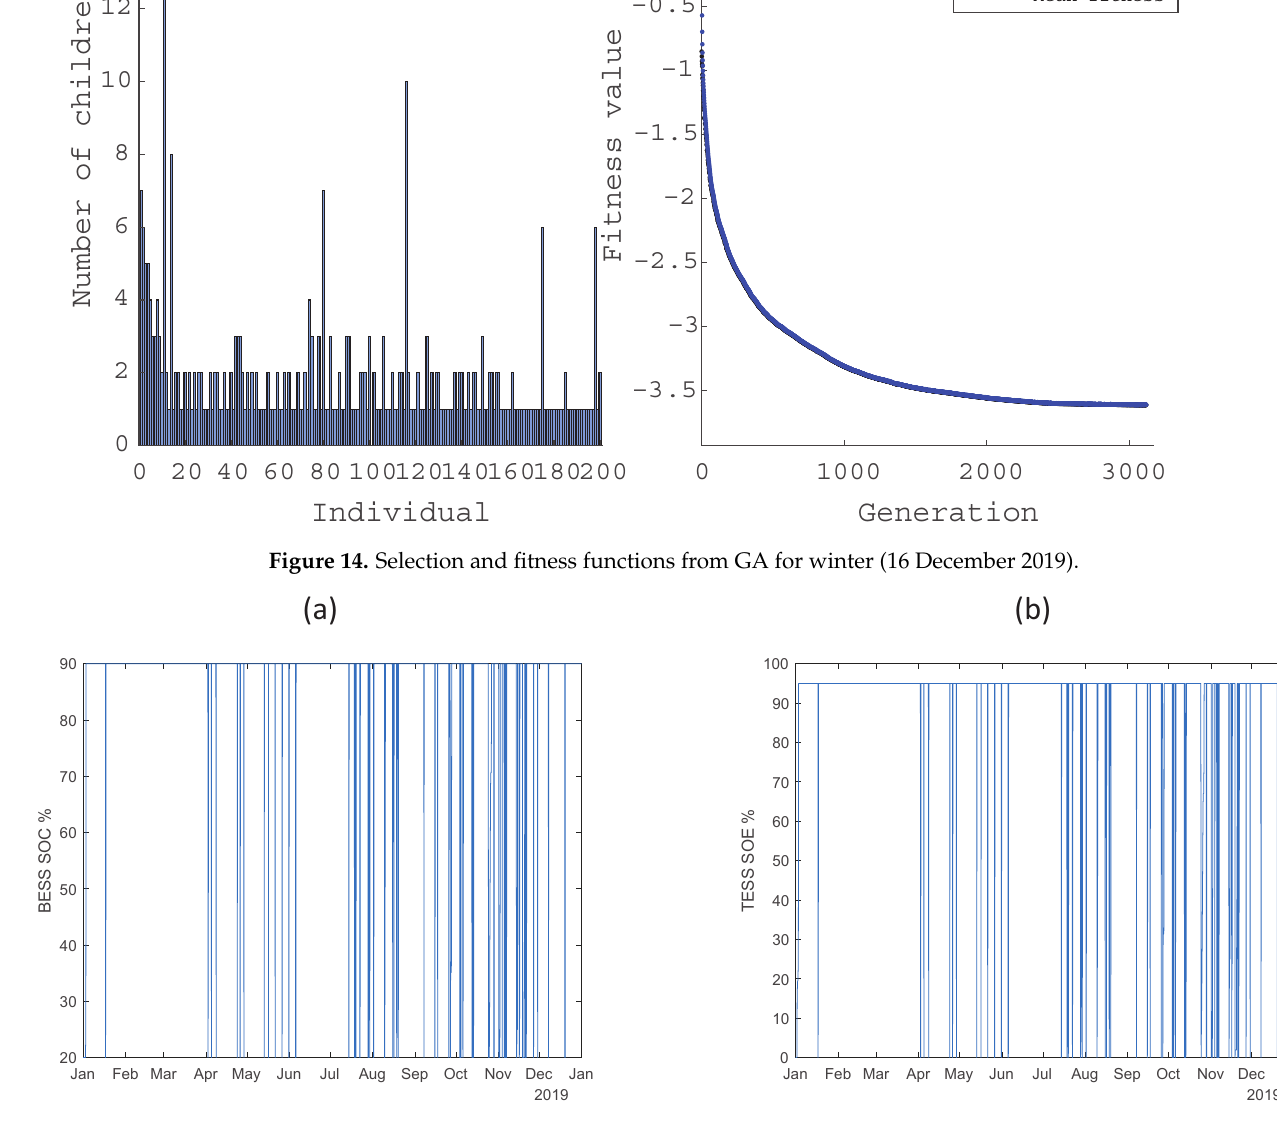
Figure 15. SoC/SoE results for both ( a ) BESS and ( b ) TESS.